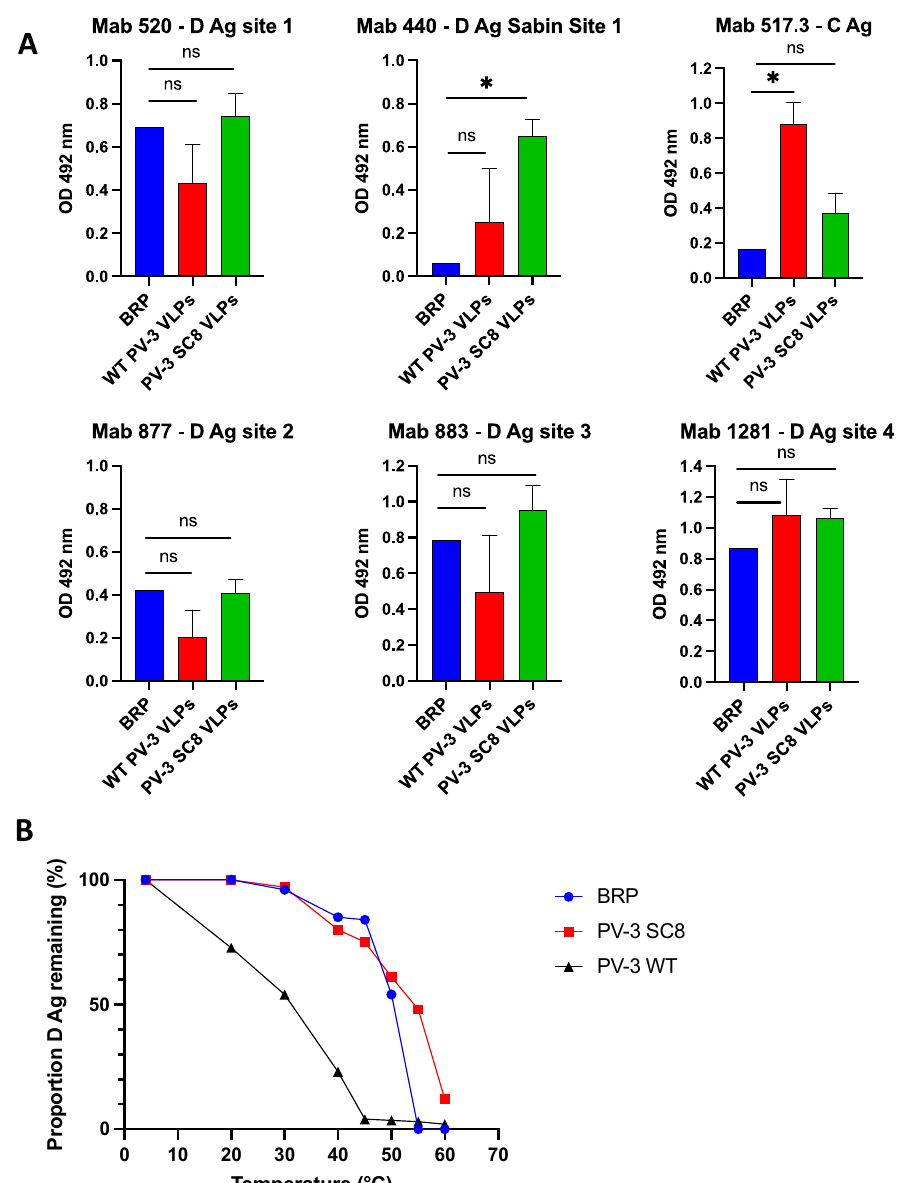
Figure 3. Antigen mapping and thermostability. ( A ): Antigen mapping of yeast-derived PV-3 wt and PV-3 SC8 VLPs. Reactivity of concentrated VLPs and BRP with PV3 Mabs specific for different antigenic sites by ELISA. OD 492 nm is represented in arbitrary units (n = 3) Means +/ − standard deviation. Statistical analysis determined by two-tailed t -test (ns, not significant; * p -value > 0.05) ( B ): Reactivity of PV-3 SC8 VLP, PV-3 wt VLPs and BRP aliquots to D-antigen specific Mab 520 in ELISA after incubation at different temperatures for 10 min, normalised to corresponding aliquot incubated at 4 °C. The figure is a representative example of three separate experiments.